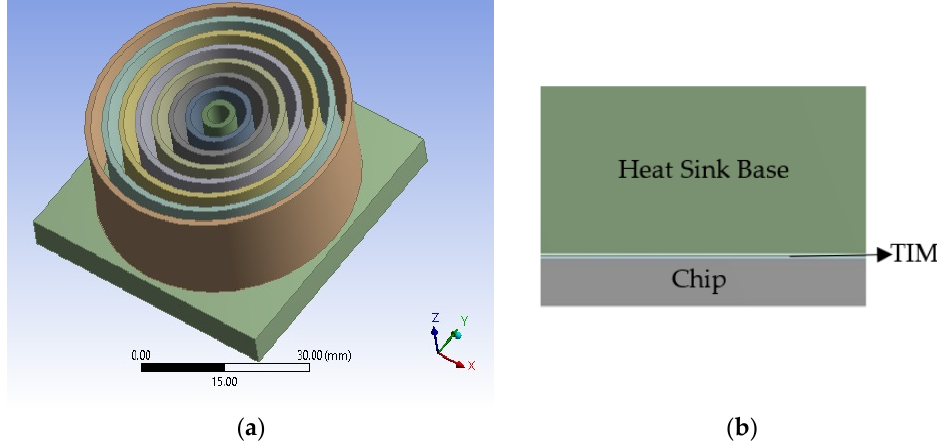
Figure 1. ( a ) Geometry of the developed model ( b ) Expanded view showing